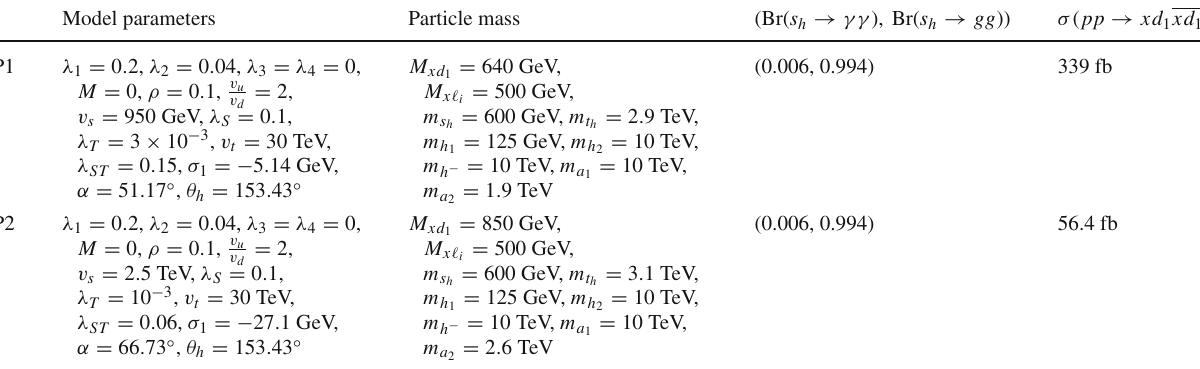
Table 4 Two benchmark scenarios. The cross section is evaluated at the 13 TeV LHC. Note that y SD